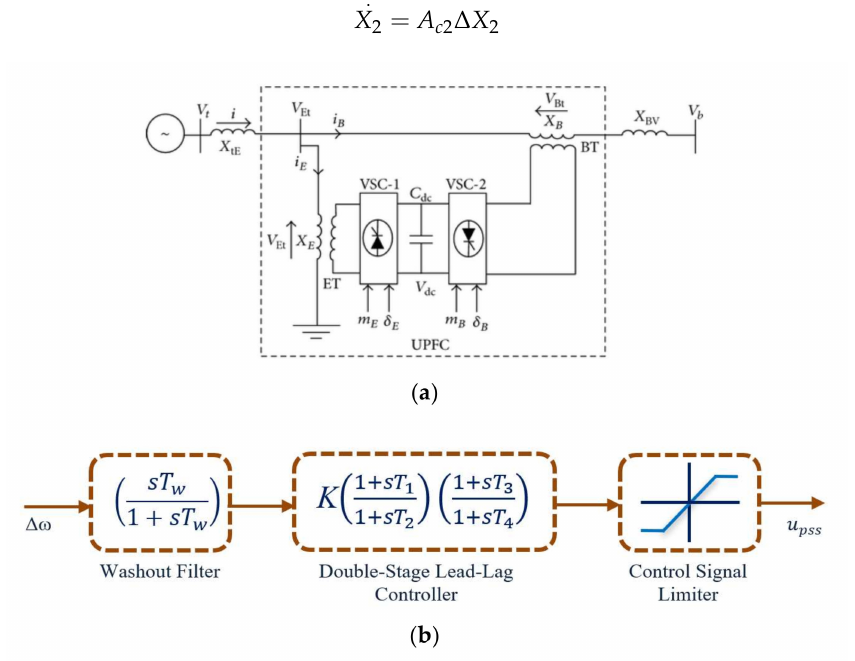
Figure 2. Second test network; ( a ) SMIB system with unified power flow controller (UPFC) coordinated PSS [40] and ( b ) double-stage lead-lag PSS